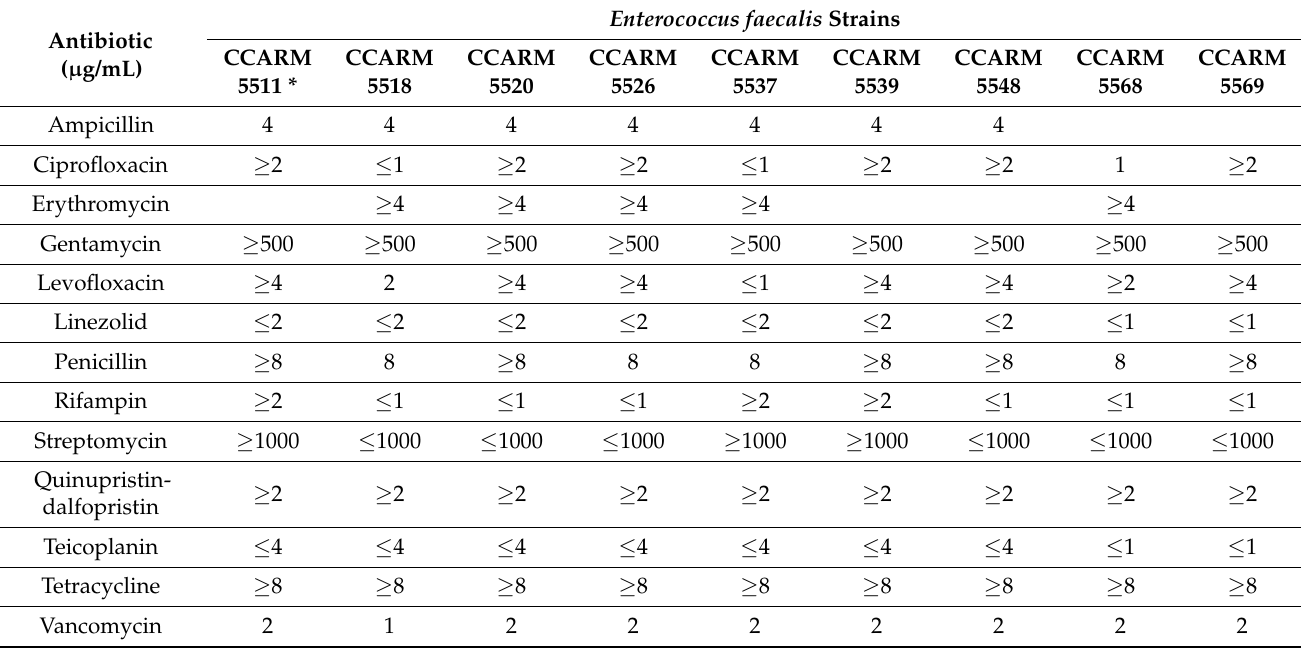
Table 1. Antibiotic resistance profiles of E. faecalis strains used in this